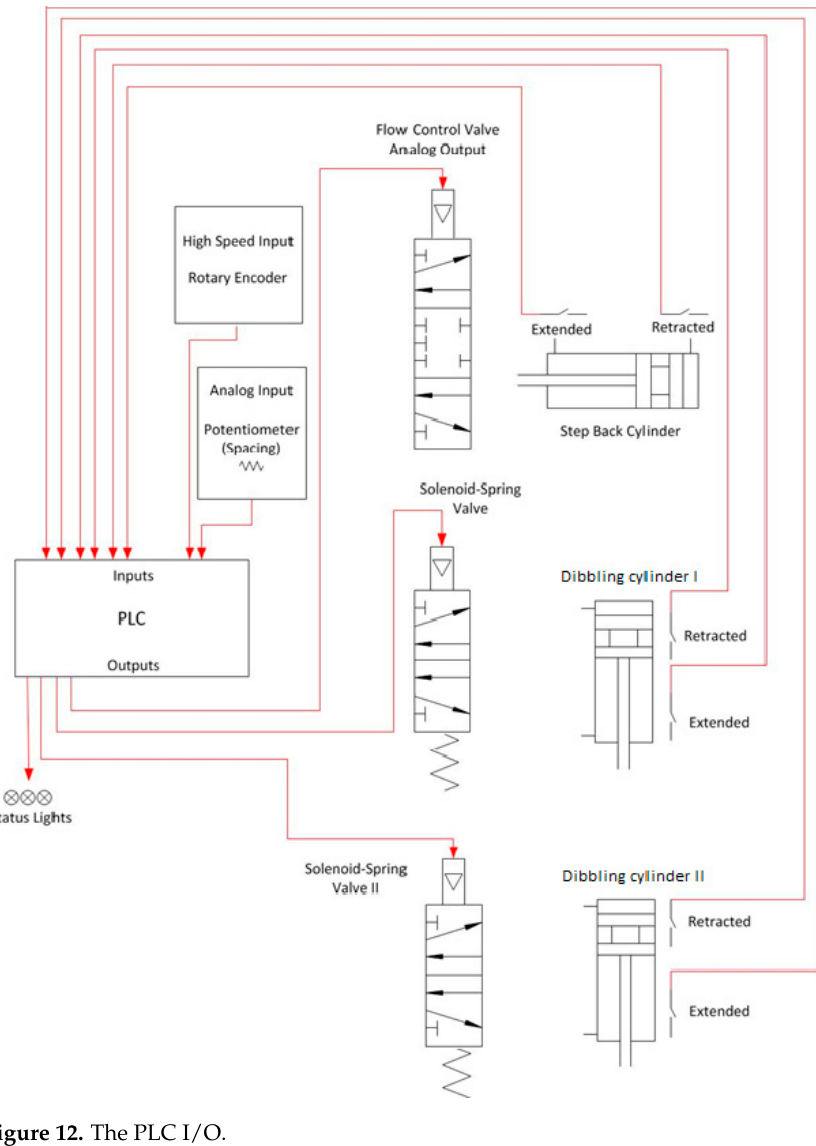
Figure 12. The PLC I/O.